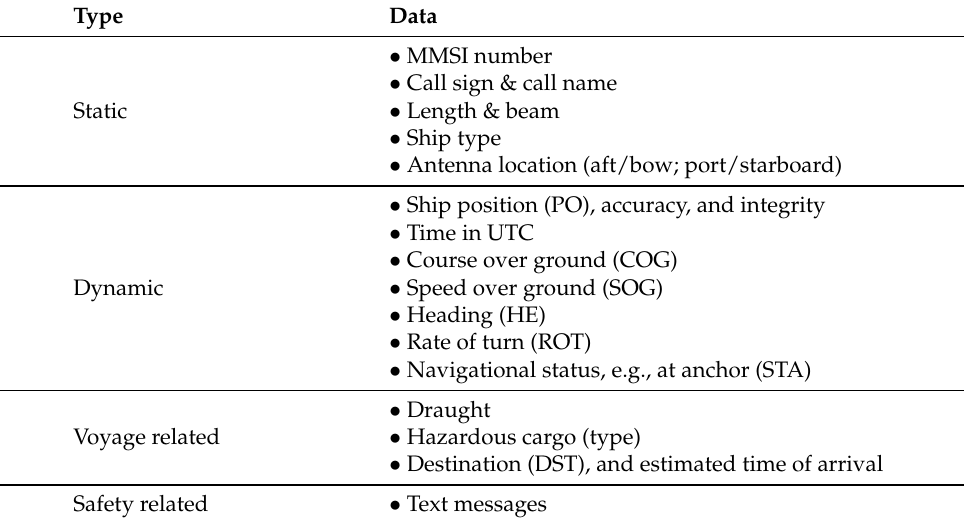
Table 1. Information announced via AIS messages. Content of the table adapted and slightly modified from IMO Resolution MSC.74 (69)